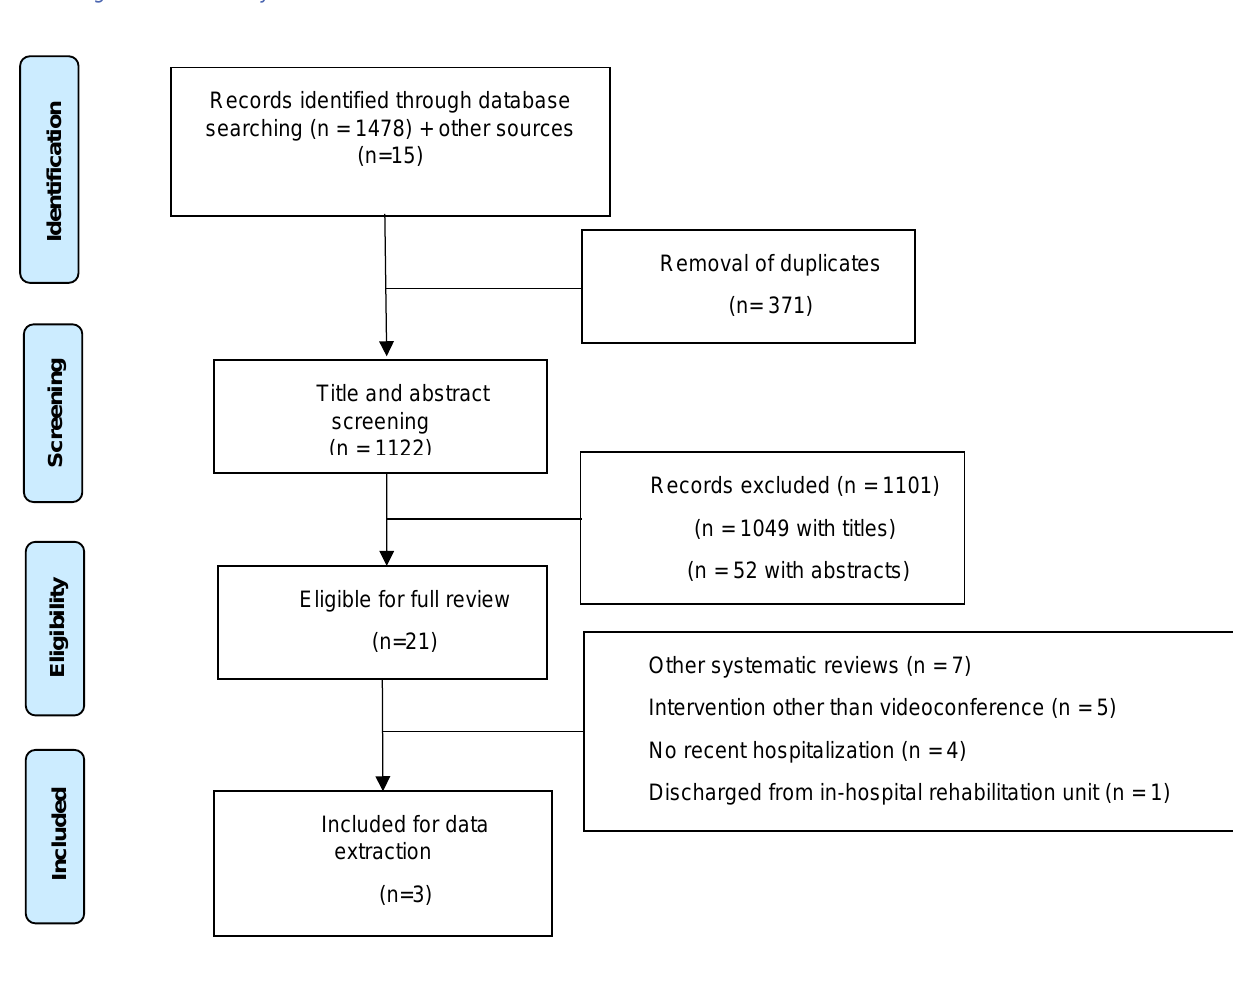
Flow Diagram of the Study Selection